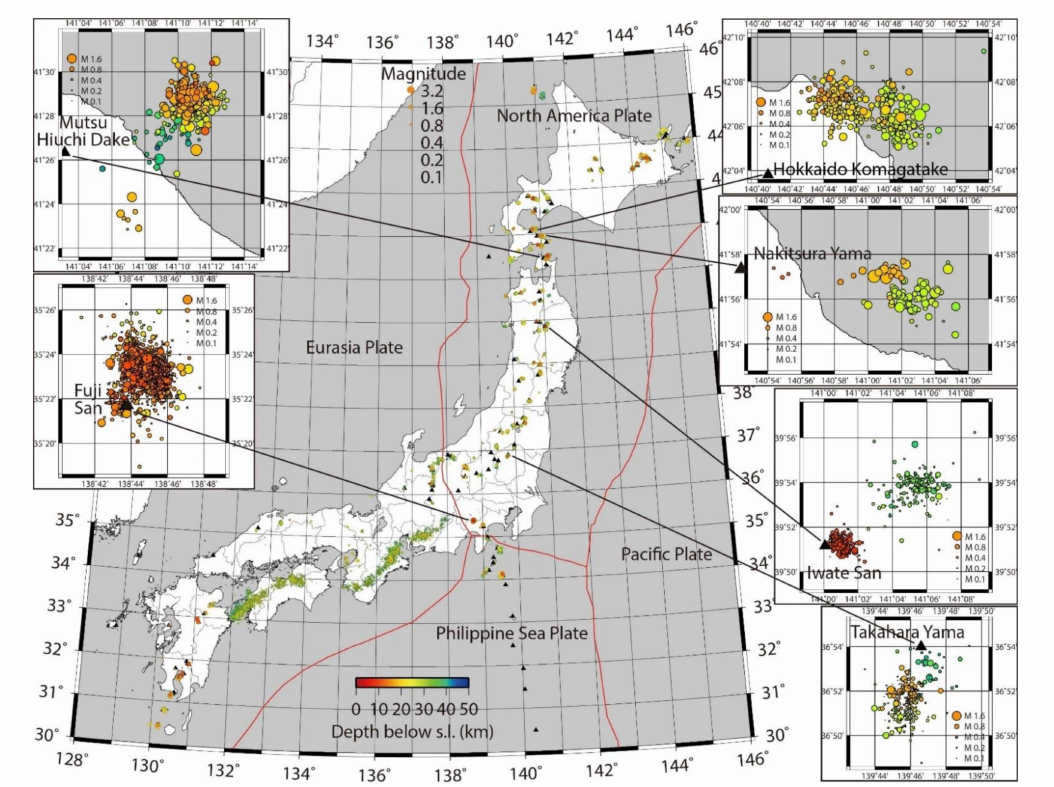
Figure 1. Distribution of 46,657 epicenters of deep low-frequency earthquakes (LFEs) on the plan views in the main part of Japan quoted from the earthquake catalog of the Japan Meteorological Agency (JMA) from the year 2000 to 2016. Solid triangles show the Quaternary volcanoes. Plan views of epicenters of LFEs of six volcanic fields are enlarged in